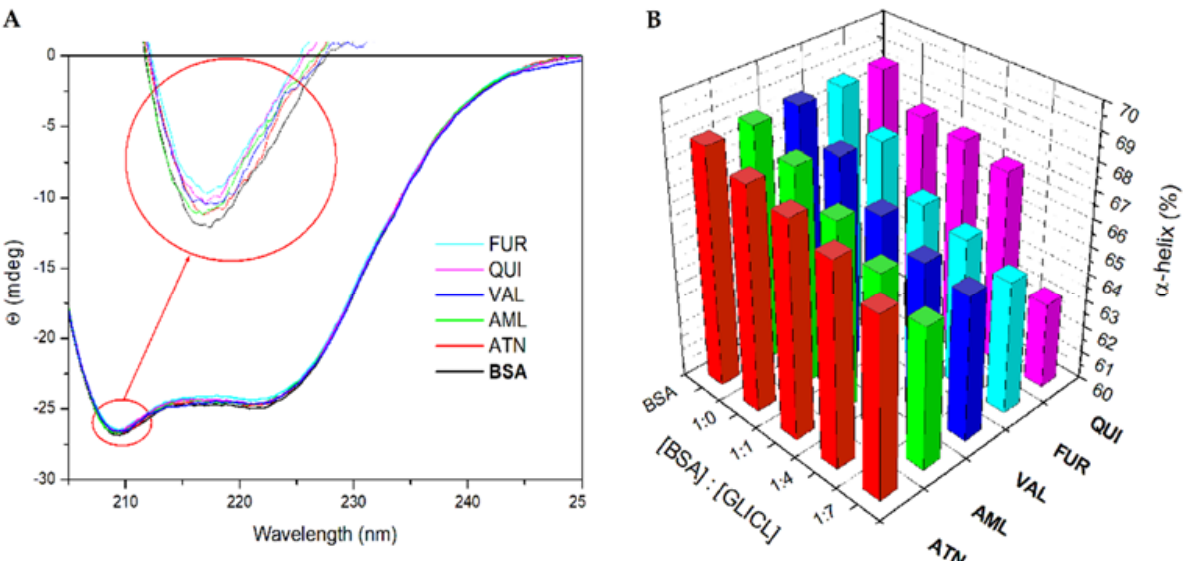
Figure 4. ( A ) Far UV–CD spectra of BSA and BSA–DRUG system (DRUG: atenolol (ATN), amlodipine besylate (AML), quinapril hydrochloride (QUI), valsartan (VAL), furosemide (FUR)). ( B ) Percentage changes of alpha-helical content of BSA upon binding with gliclazide in presence of drug ligands.